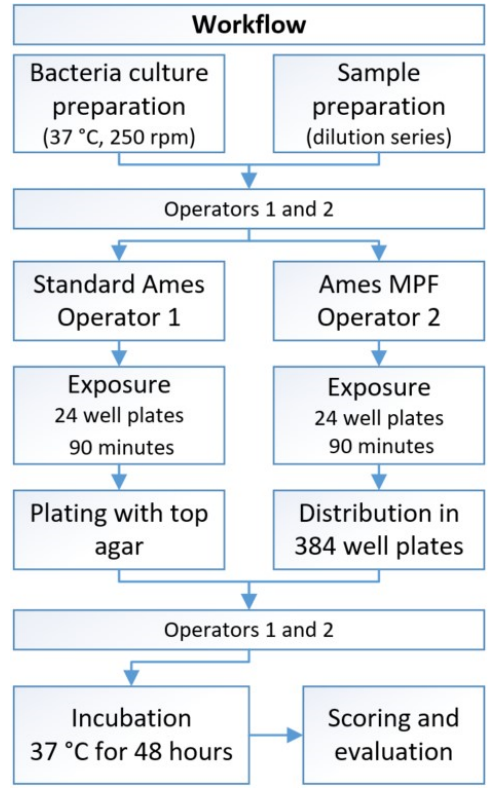
Figure 1. Visualization of the workflow for the comparison of the different Ames protocols.